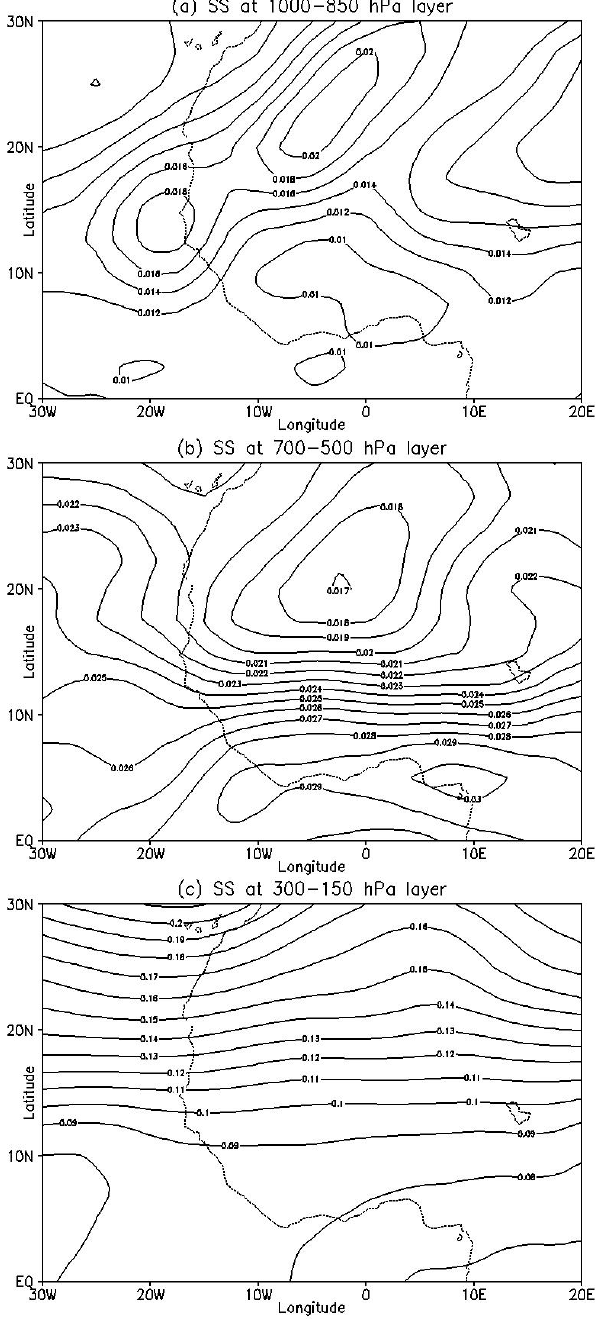
Fig. 1. Spatial variations of mean static stability (in m 2 s − 1 Pa − 1 ) over West Africa and Northern Atlantic during summer (JJAS) for the period 1979–2005 at layers (a) 1000–850hPa, (b) 700–500hPa and (c) 300–150hPa. The map of West Africa is depicted as a − 1 short dash line. Contour interval for (a) is 2 × 10 − 3 m 2 s − 1 Pa , − 1 − 1 (b) 10 − 3 m 2 s − 1 Pa and (c) 10 − 2 m 2 s − 1 Pa